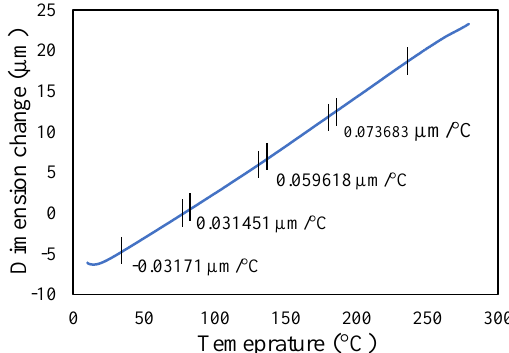
Figure 8. Thermal expansion of 0.5 mm crack depth specimen.